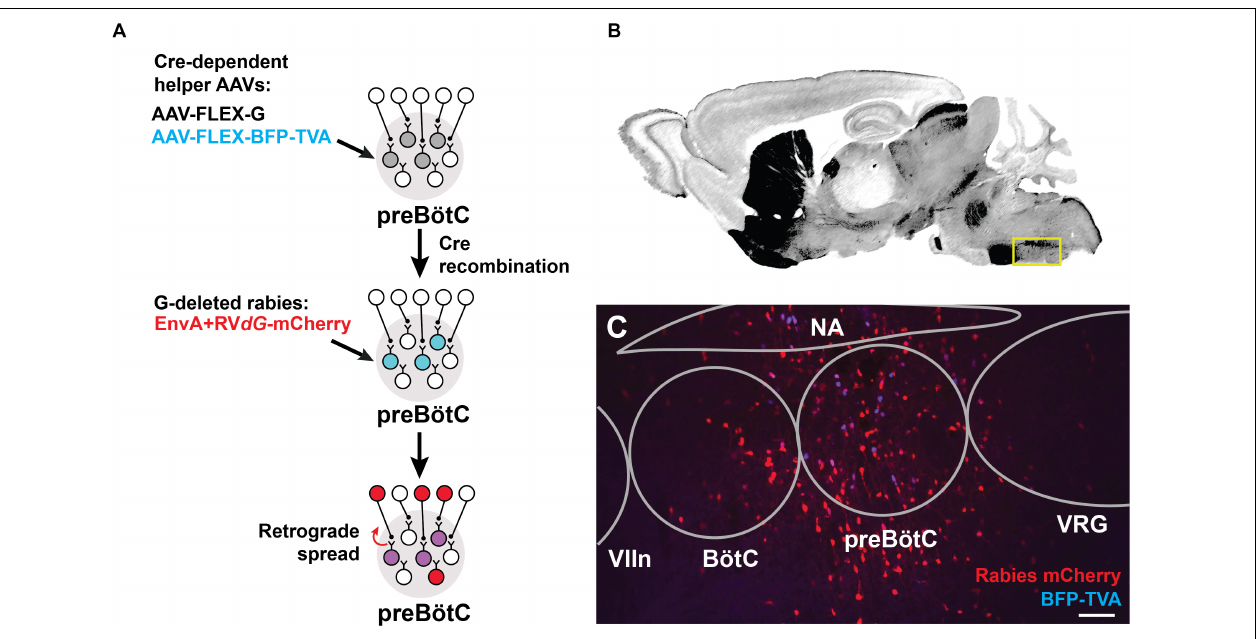
FIGURE 1 | Targeting modified rabies to the preBötC. (A) Viral strategy for monosynaptic retrograde labeling of preBötC neurons. Stereotaxic injection of Cre-dependent helper AAVs into the preBötC of SST- or GlyT2-Cre mice leads to transfection of cells (gray). Only Cre+ cells express TVA receptor/BFP and glycoprotein, enabling subsequent rabies infection and retrograde spread (blue). Injection of EnvA + RV dG -mCherry leads to localized expression of mCherry and BFP in SST+ or GlyT2+ starter cells (purple) and retrograde transport across a single synapse (red). (B) Reference sagittal section (Paxinos and Franklin, 2004) at the level of the preBötC (yellow box) with acetylcholinesterase staining. (C) AAV injection into GlyT2-Cre mouse leads to mCherry + /BFP + expression in the cell bodies (co-labeled starter cells) and monosynaptic, retrogradely labeled cells (red). (VIIn, facial nucleus; VRG, ventral respiratory group), Scale bar = 100 µ m.